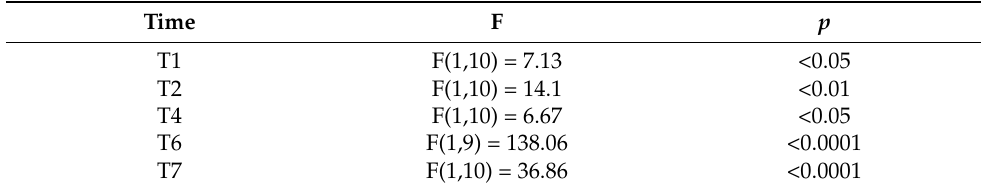
Table 6. ANOVA summery table. Significant differences in Wdhn13 gene transcript between FI and RI conditions during the time-course.